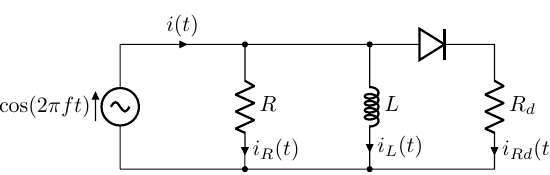
Figure 5. Computer simulation model for testing the CPT transducer with different AMAs.